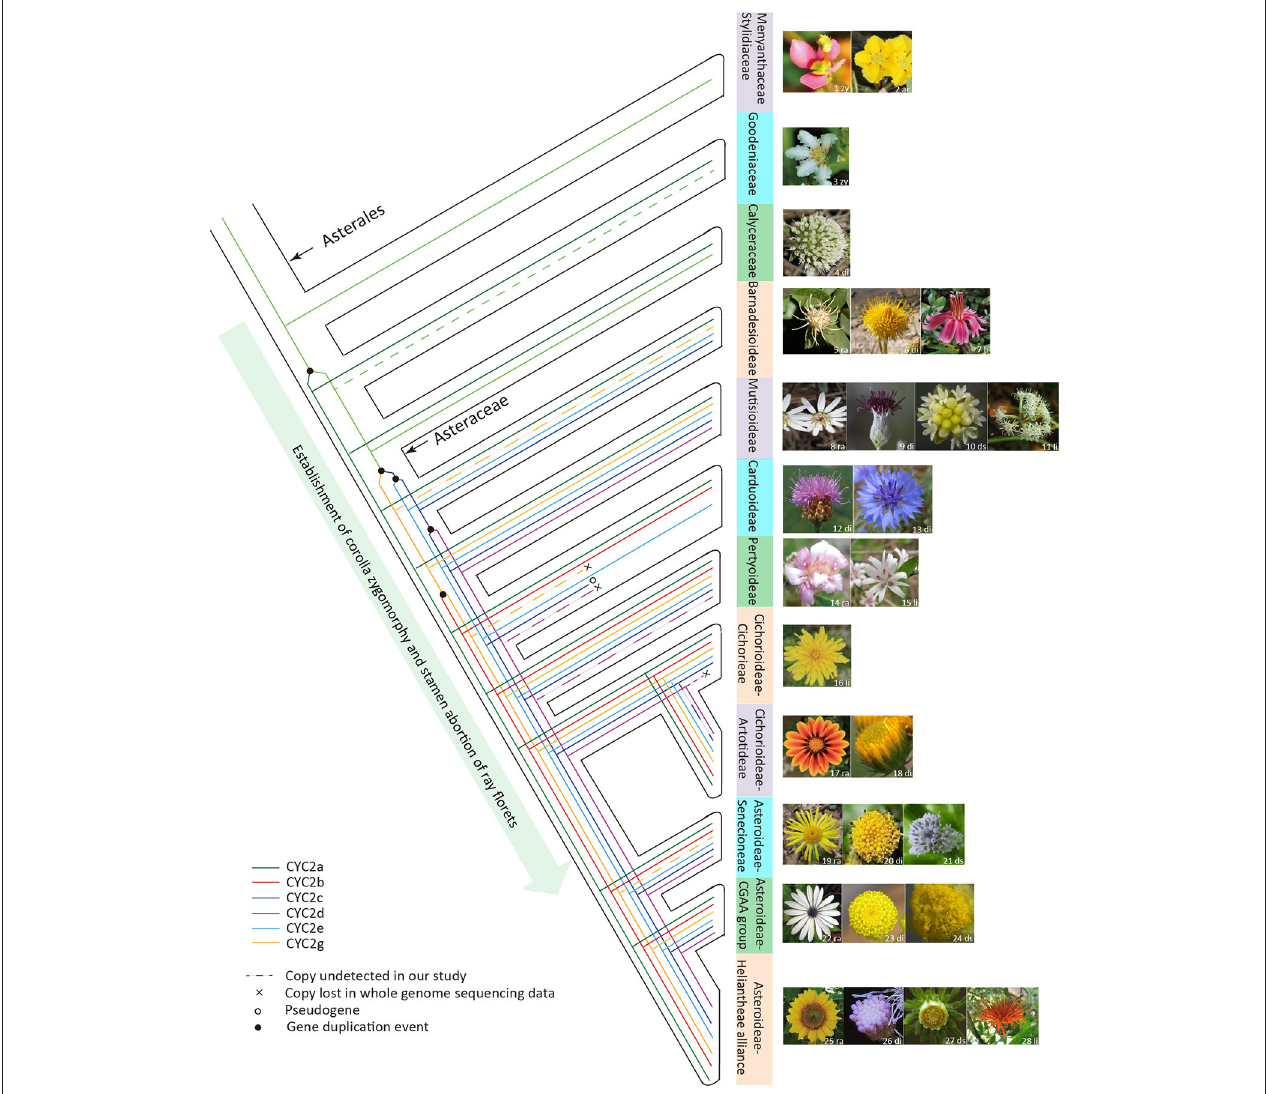
FIGURE 6 | The hypothesized evolutionary trajectory of the Asteraceae capitulum architecture in relation to the evolution of the CYC2 -like genes. The phylogeny framework of Asterales is depicted according to Panero and Funk (2008), Funk et al. (2009) and APG IV (Chase et al., 2016). Images of the typical flower or inflorescence/capitulum are attached to taxon branches. Abbreviations on the floral images denote the floral symmetry or capitulum type: zy, zygomorphy; ac, actinomorphy; ra, radiate; di, discoid; li, liguliflorous; ds, disciform. Sources of flora images are indicated by the numbers on the photos: 1, 2, 8, 10, 14–17, 22–25, and 27 were photographed by the present authors; 9 is cited from Panero et al. (2014); 3–4, 6, 11, and 28 are from Wikipedia (https://www.wikipedia.org/); 5, 18 and 21 from the website https://www.flickr.com/photos; 7 from http://flickriver.com/photos/grandma-shirley/7181225103/; 12 from http://www.cd-pa.com; 13 from http://www.naturspaziergang.de; 19 from http://luirig.altervista.org; 20 from https://image.baidu.com; 26 from